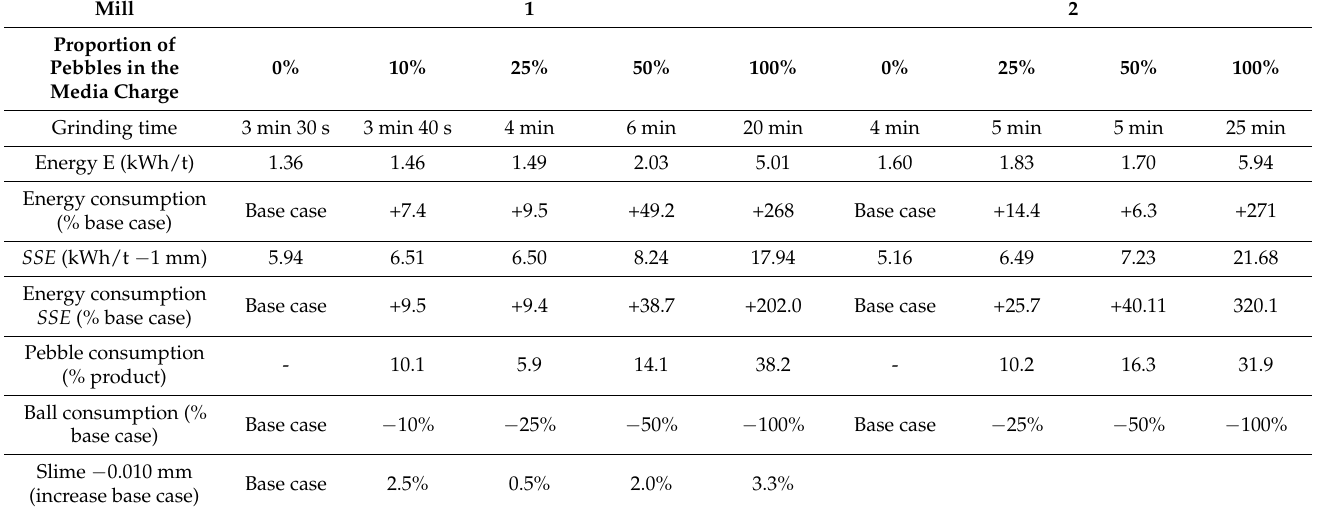
Table 5. Primary grinding test results.